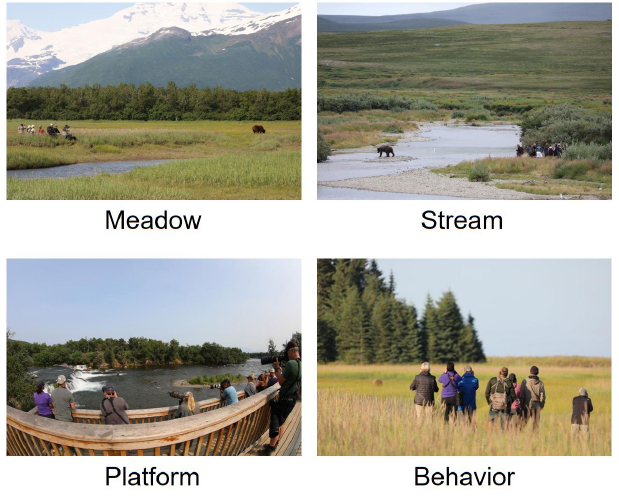
Fig. 1 . Images shown to respondents prior to viewing the respective setting and behavior treatment